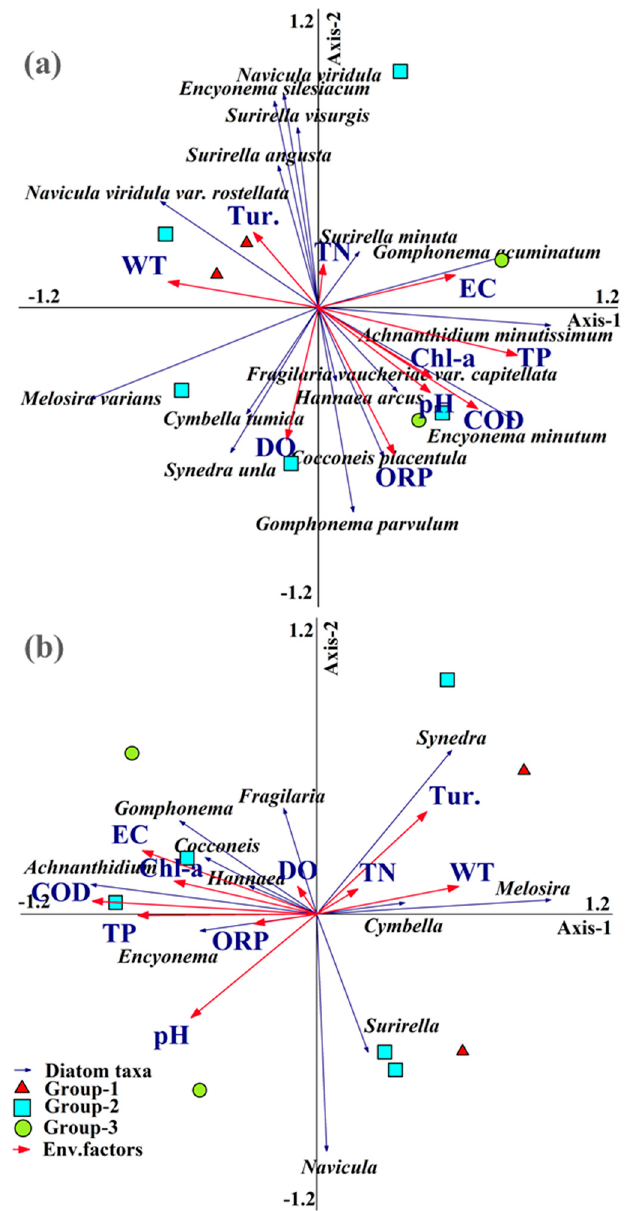
Figure 5. Redundancy analysis (RDA) ordinations of diatom species level ( a ), genus level ( b ) and sampling station with 9 environmental factors.